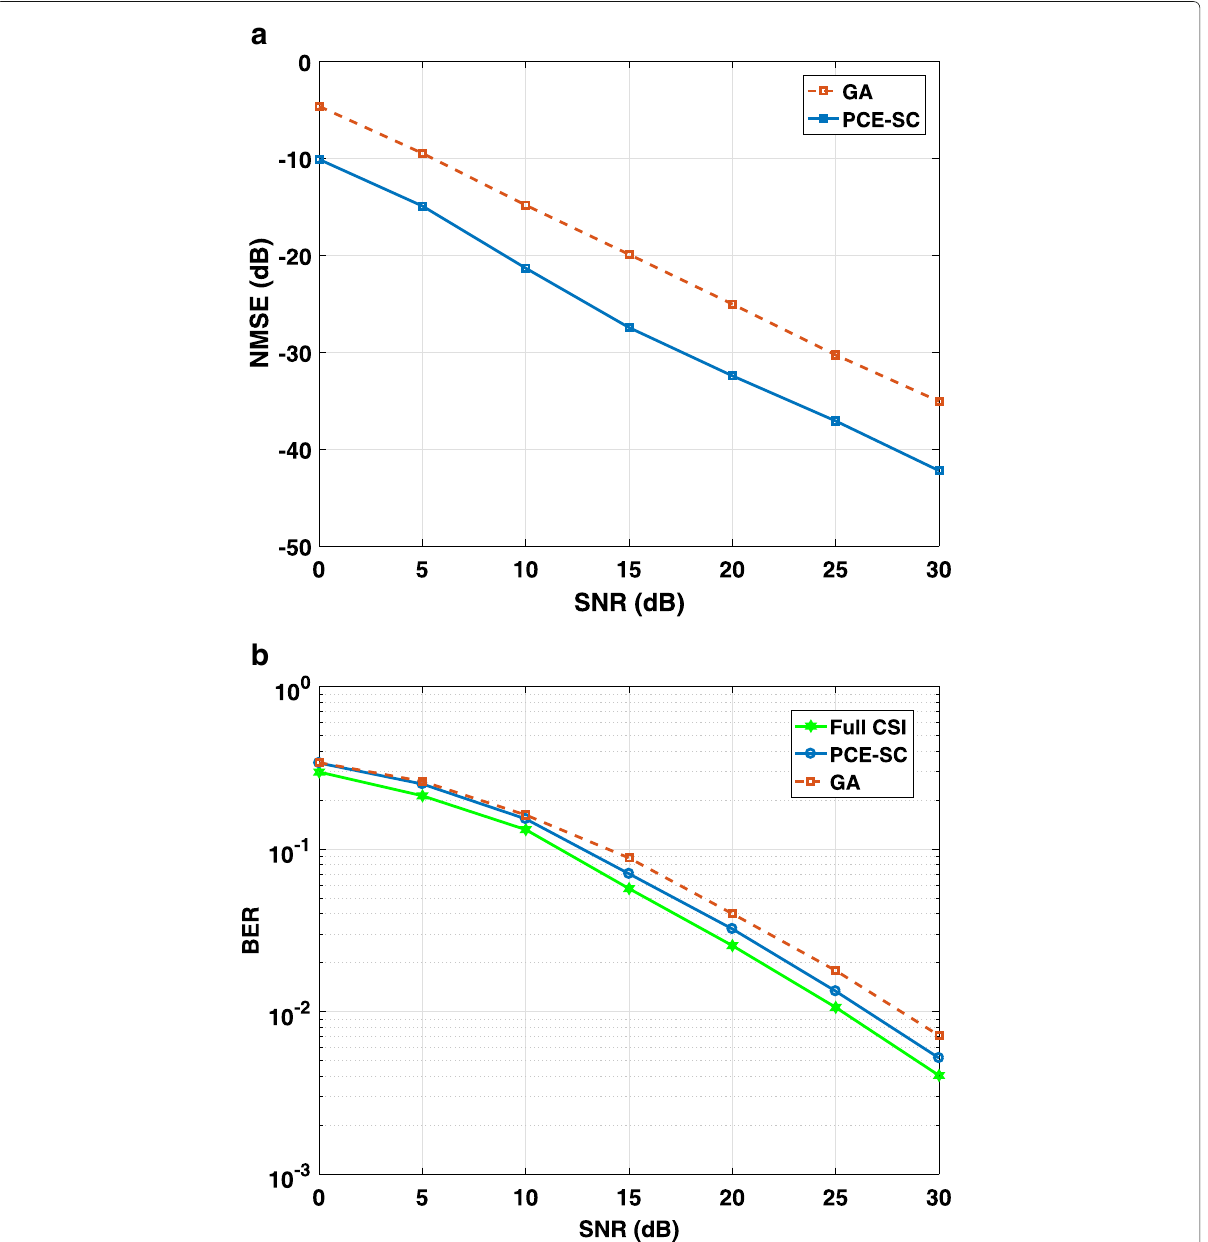
Fig. 5 Performance comparison of proposed method and GA-based pilot allocation algorithm: a NMSE performance metric and b BER performance metric